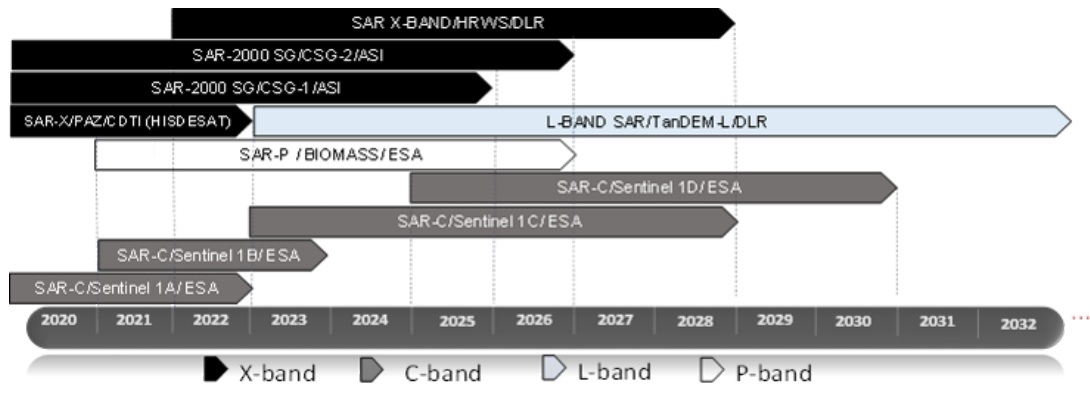
Figure 2. Frequency bands of future (2020–2030) European Union (EU) mission carrying Synthetic Aperture Radar (SAR) imager